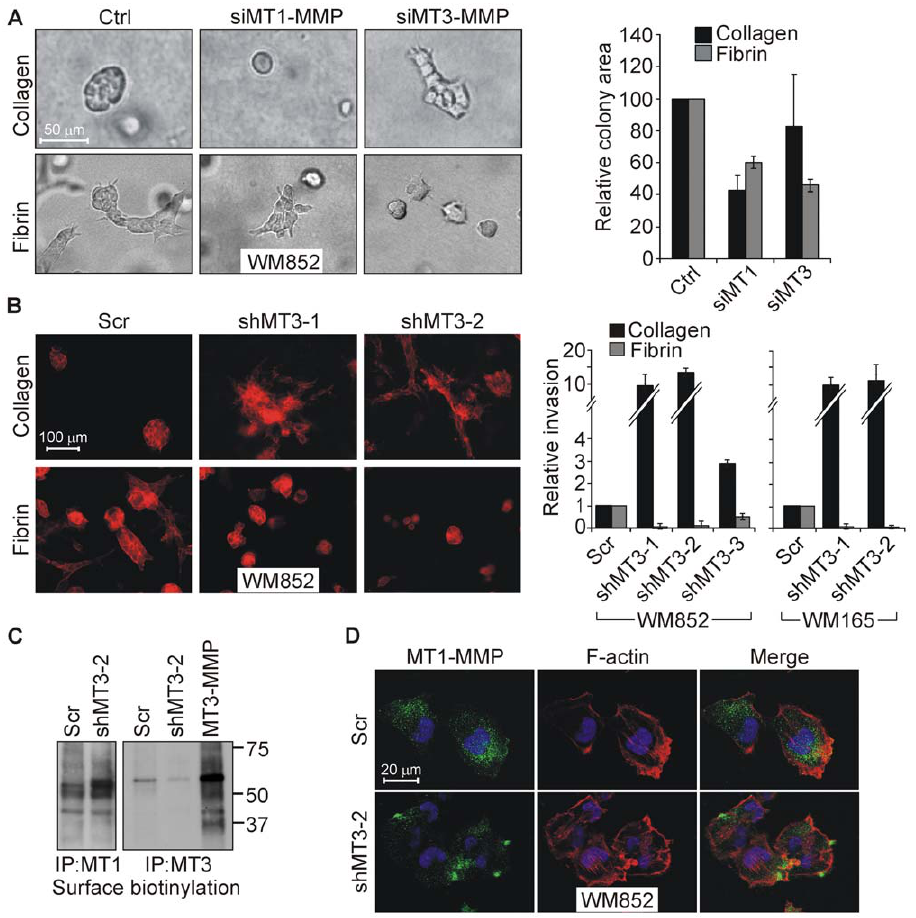
Figure 6. MT3-MMP promotes invasion in 3D fibrin and adhesive, nodular-type cell growth in 3D collagen. (A) WM852 cells transfected with the siRNAs against MT1-MMP (siMT1-MMP) and MT3-MMP (siMT3-MMP) were embedded in 3D collagen type I or fibrin gels as single cell suspension. Light micrographs show representative cell colonies that were formed after 5-d assay. Chart on the right shows the relative sizes of the cell colonies (n=3). (B) Stable WM852 and WM165 cell pools expressing control scrambled shRNA (scr) or MT3-MMP targeting shRNAs (shMT3-1, shMT3-2 and shMT3-3) were allowed to grow inside 3D collagen or fibrin gels for 14 d. The fixed 3D cultures were stained with TRITC-phalloidin and photographed (see Fig. S4D for representative micrographs of WM165 cell colonies). Chart shows relative areas of invasive sprouts. (C) Cell surface MT1-MMP and MT3-MMP were detected by surface biotinylation of stable WM852 cells expressing the most potent shRNA against MT3-MMP (shMT3- 2) or scrambled shRNA (Scr), followed by immunoprecipitation using MT1-MMP and MT3-MMP antibodies. WM852 cells after transient transfection with MT3-MMP cDNA (MT3-MMP) were used as a control for the immunoprecipitation of endogenous MT3-MMP. (D) Epifluorescence micrographs visualize the increased MT1-MMP (green) on the surface of shMT3-2 expressing cells. The cells were counterstained with DAPI for nuclei (blue) and phalloidin for filamentous actin (red).